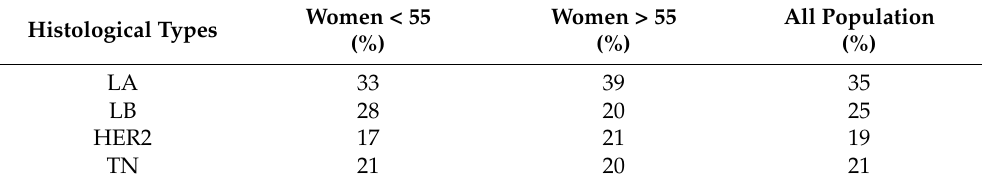
Table A1. Distribution of hormone receptors by age groups <55 and >55 in women with breast